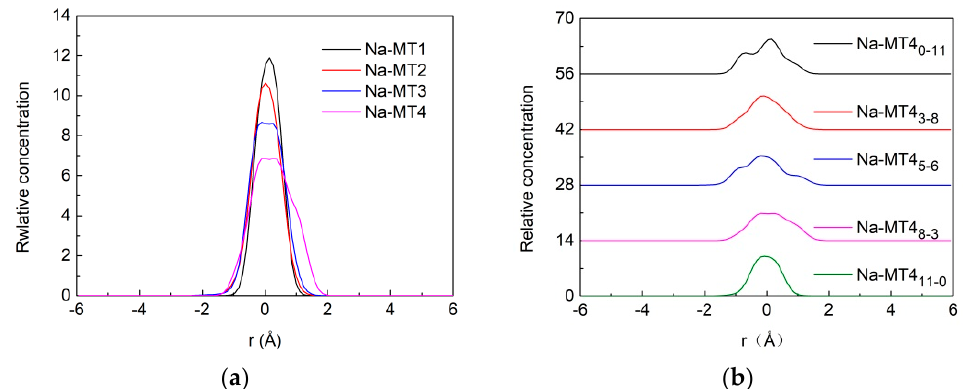
Figure 5. The z-axis concentration curves of Na + in interlayer of Na-MT, ( a ) effect of layer charge density on the distribution of Na + ; ( b ) effect of isomorphic substitution sites on the distribution of Na + in interlayer of Na-MT4 (the concentration distribution of Na + in interlayer of Na-MT1, Na-MT2 and Na-MT3 is similar to that of Na-MT4, thus here only Na-MT4 is displayed.)